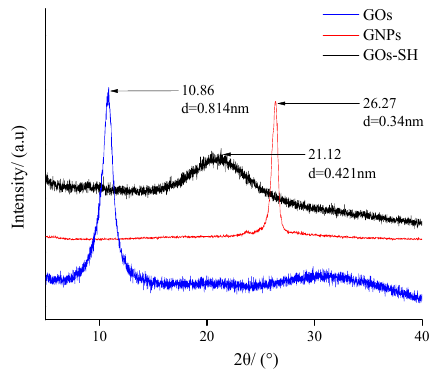
Figure 14. XRD patterns of GOs, GNPs, and GOs-SH.